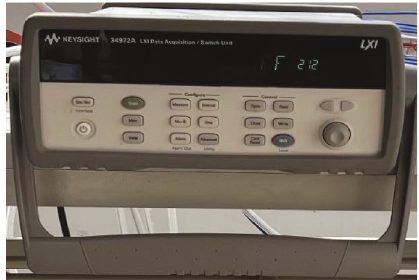
Figure 3: Keysight temperature recorder.